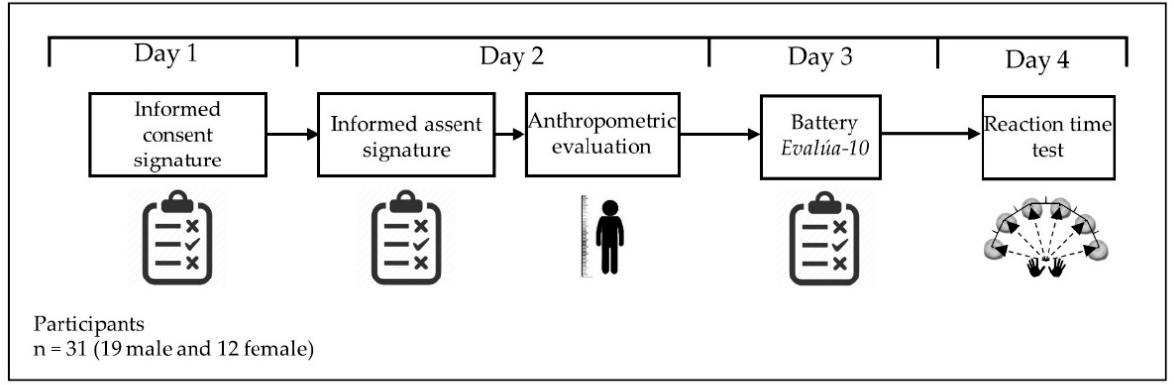
Figure 1. Research